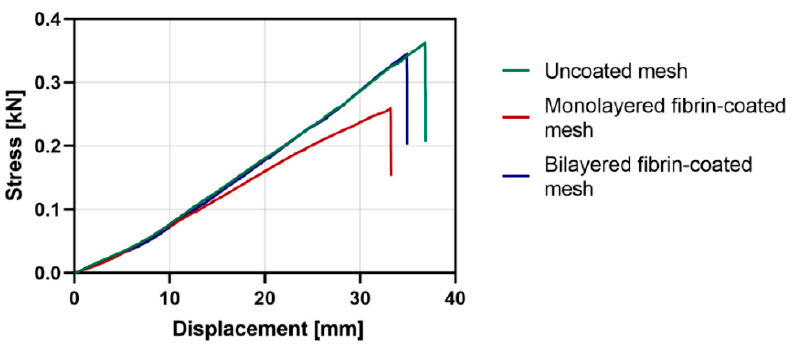
Table 1. Uniaxial tensile test results of uncoated and fibrin-coated polypropylene surgical mesh. Monolayered and bilayered fibrin coatings were performed with 5 mg/mL fibrinogen and 5.5 IU/mL thrombin solutions in PBS. For each condition, breaking load, elongation at break, and Young mod- ulus were calculated following mechanical testing.